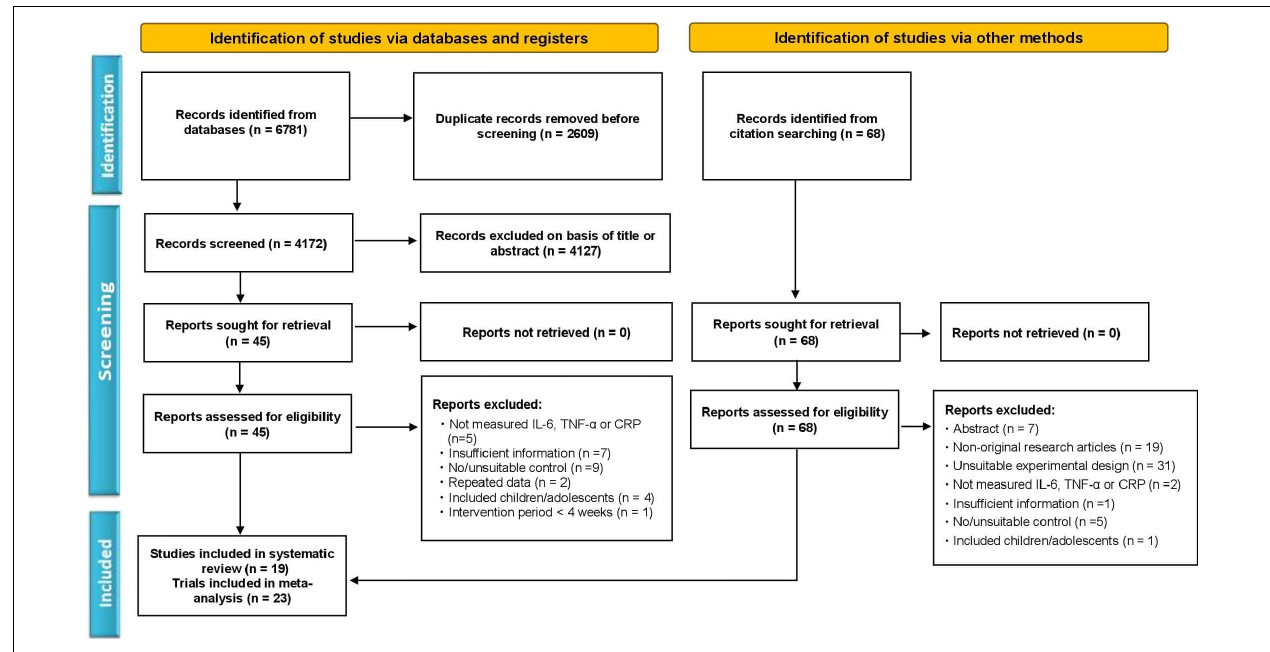
FIGURE 1 | Flowchart of the study selection according to the Preferred Reporting Items for the Systematic Reviews and Meta-Analysis (PRISMA)